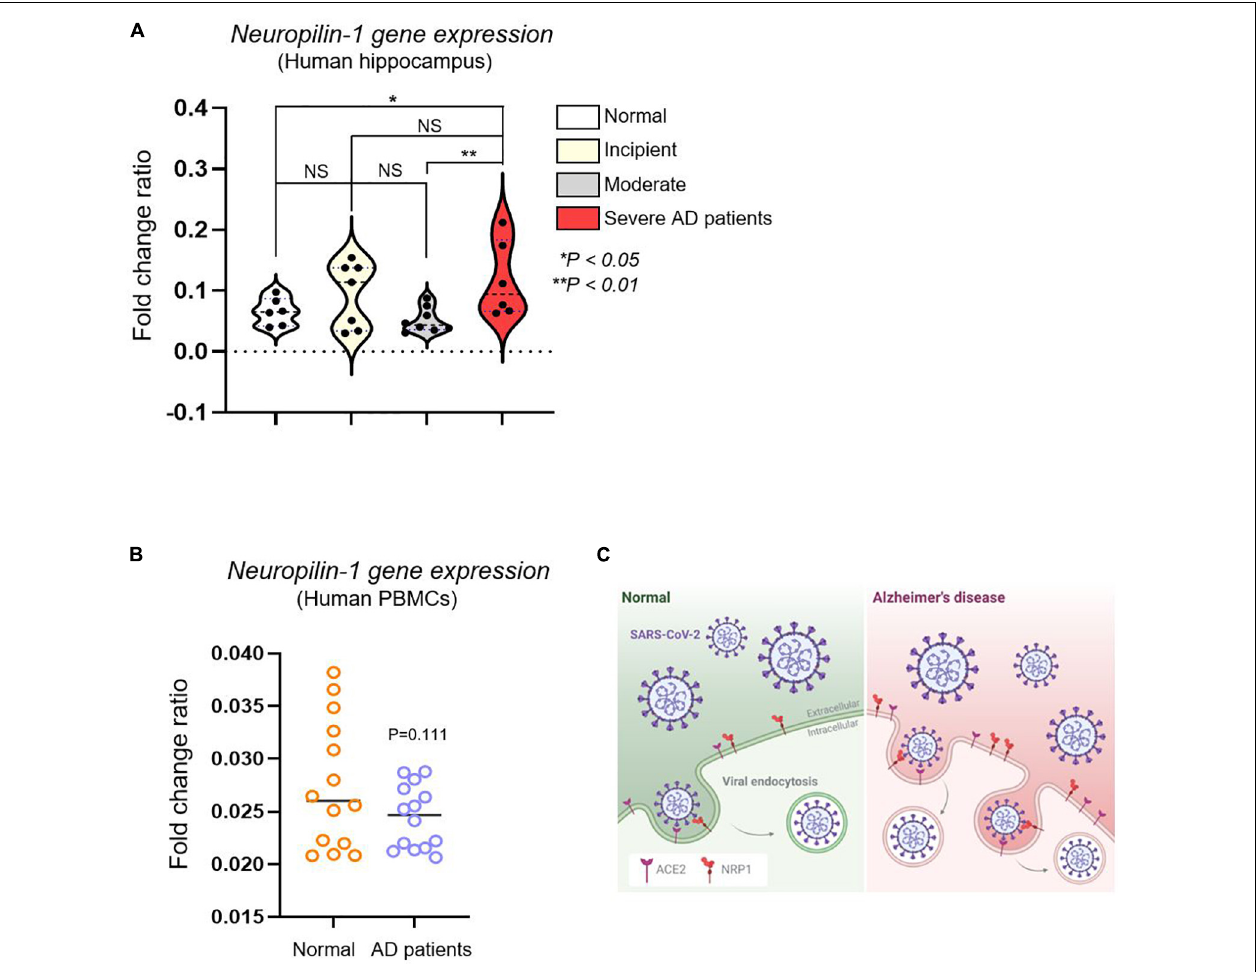
FIGURE 3 | In silico analysis of Nrp1 gene expression in human hippocampus and PBMCs from AD patients. (A) Nrp1 expression is significantly increased in the human hippocampus of severe AD patients compared with that in the control group (179%). No statistical difference is observed when WT is compared to incipient and moderate AD patients. Normal control group n = 6, incipient group n = 7, moderate group n = 8, and severe group n = 6. Statistical differences were assessed using post hoc test after one-way ANOVA. (B) Nrp1 expression in PBMCs from AD patients is not statistically different from that in the control group. Normal elderly control, female n = 7 and male n = 7; AD patient group, female n = 7 and male n = 7. Statistical differences were assessed using unpaired t -test. (C) Schematic model of NRP1- and ACE2-mediated SARS-CoV-2 infection in AD. NRP1 and ACE2 mediate SARS-CoV-2 binding to the cell membrane and, consequently, infection. Because these two receptors are highly expressed in AD patients, these individuals may be more sensitive to SARS-CoV-2 infection.